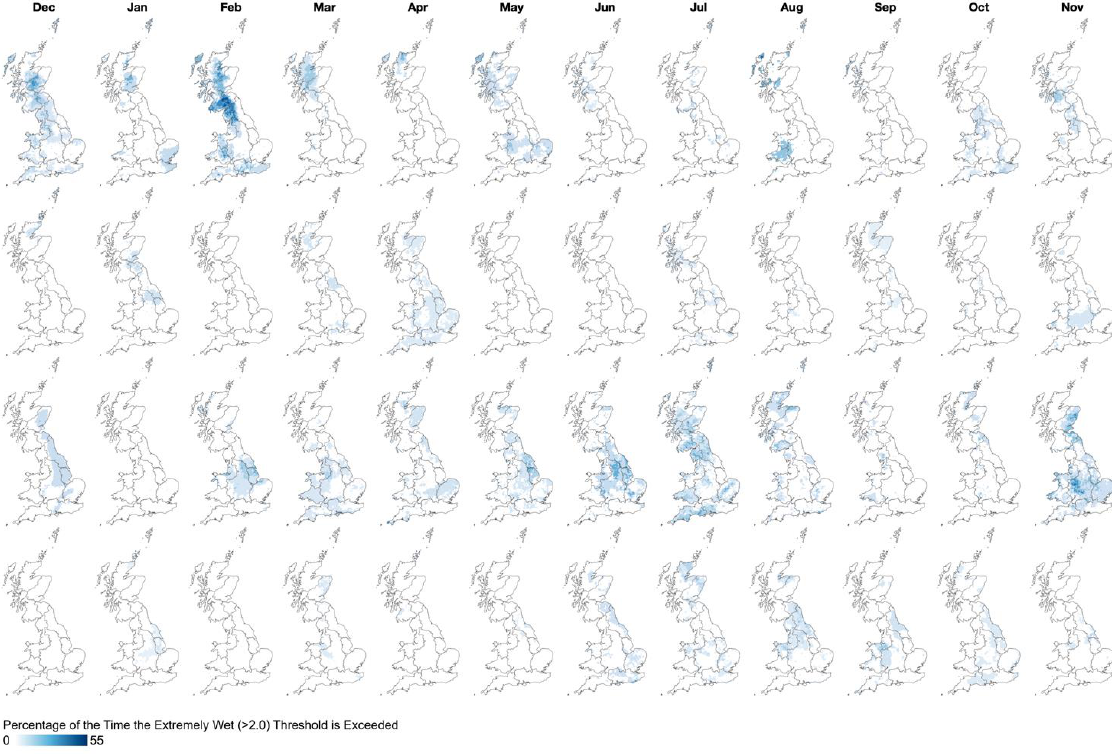
Figure 10. As per Figure 7 but for the severely dry (SPI-1 < − 1.5) SPI-1 class.